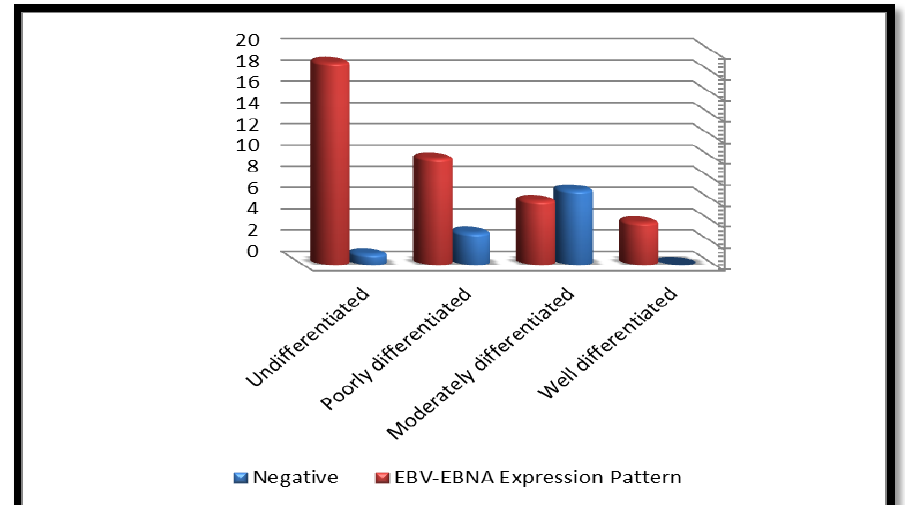
Figure 1. Expression of EBNA-EBV in diagnostic